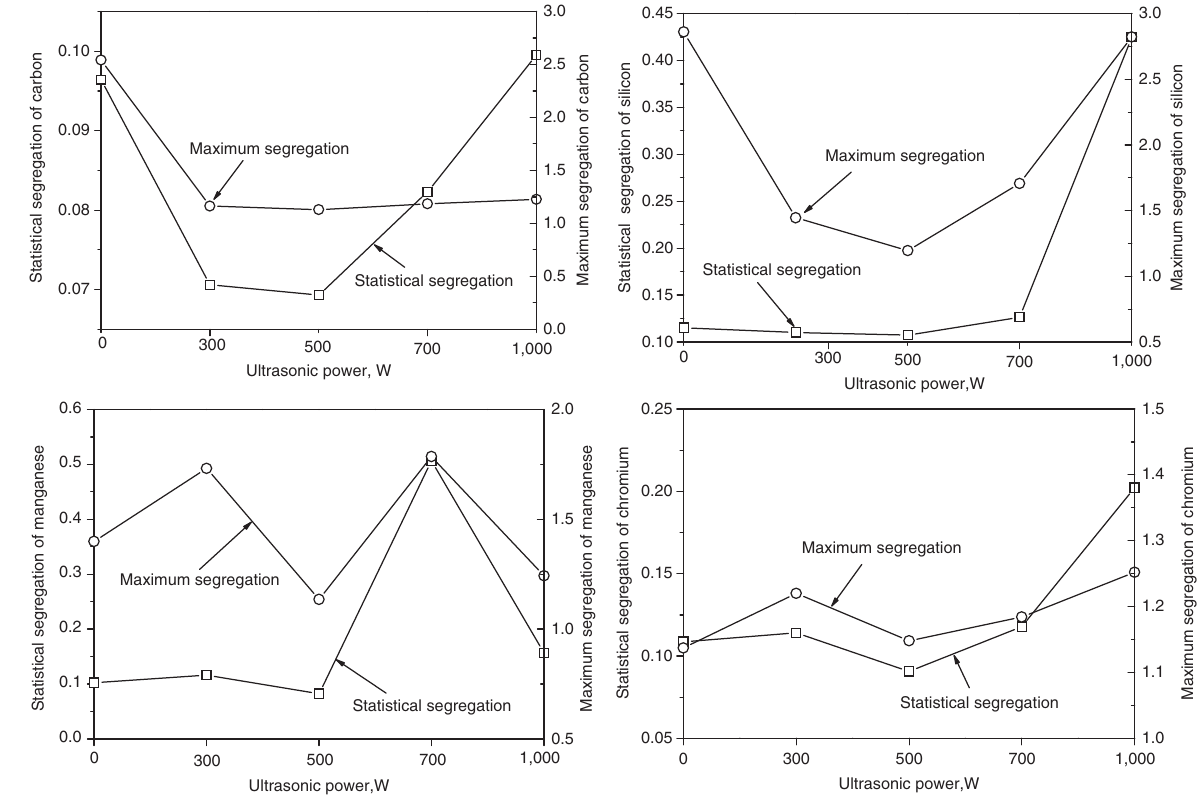
Figure 5: Relation between the segregation and ultrasonic power.